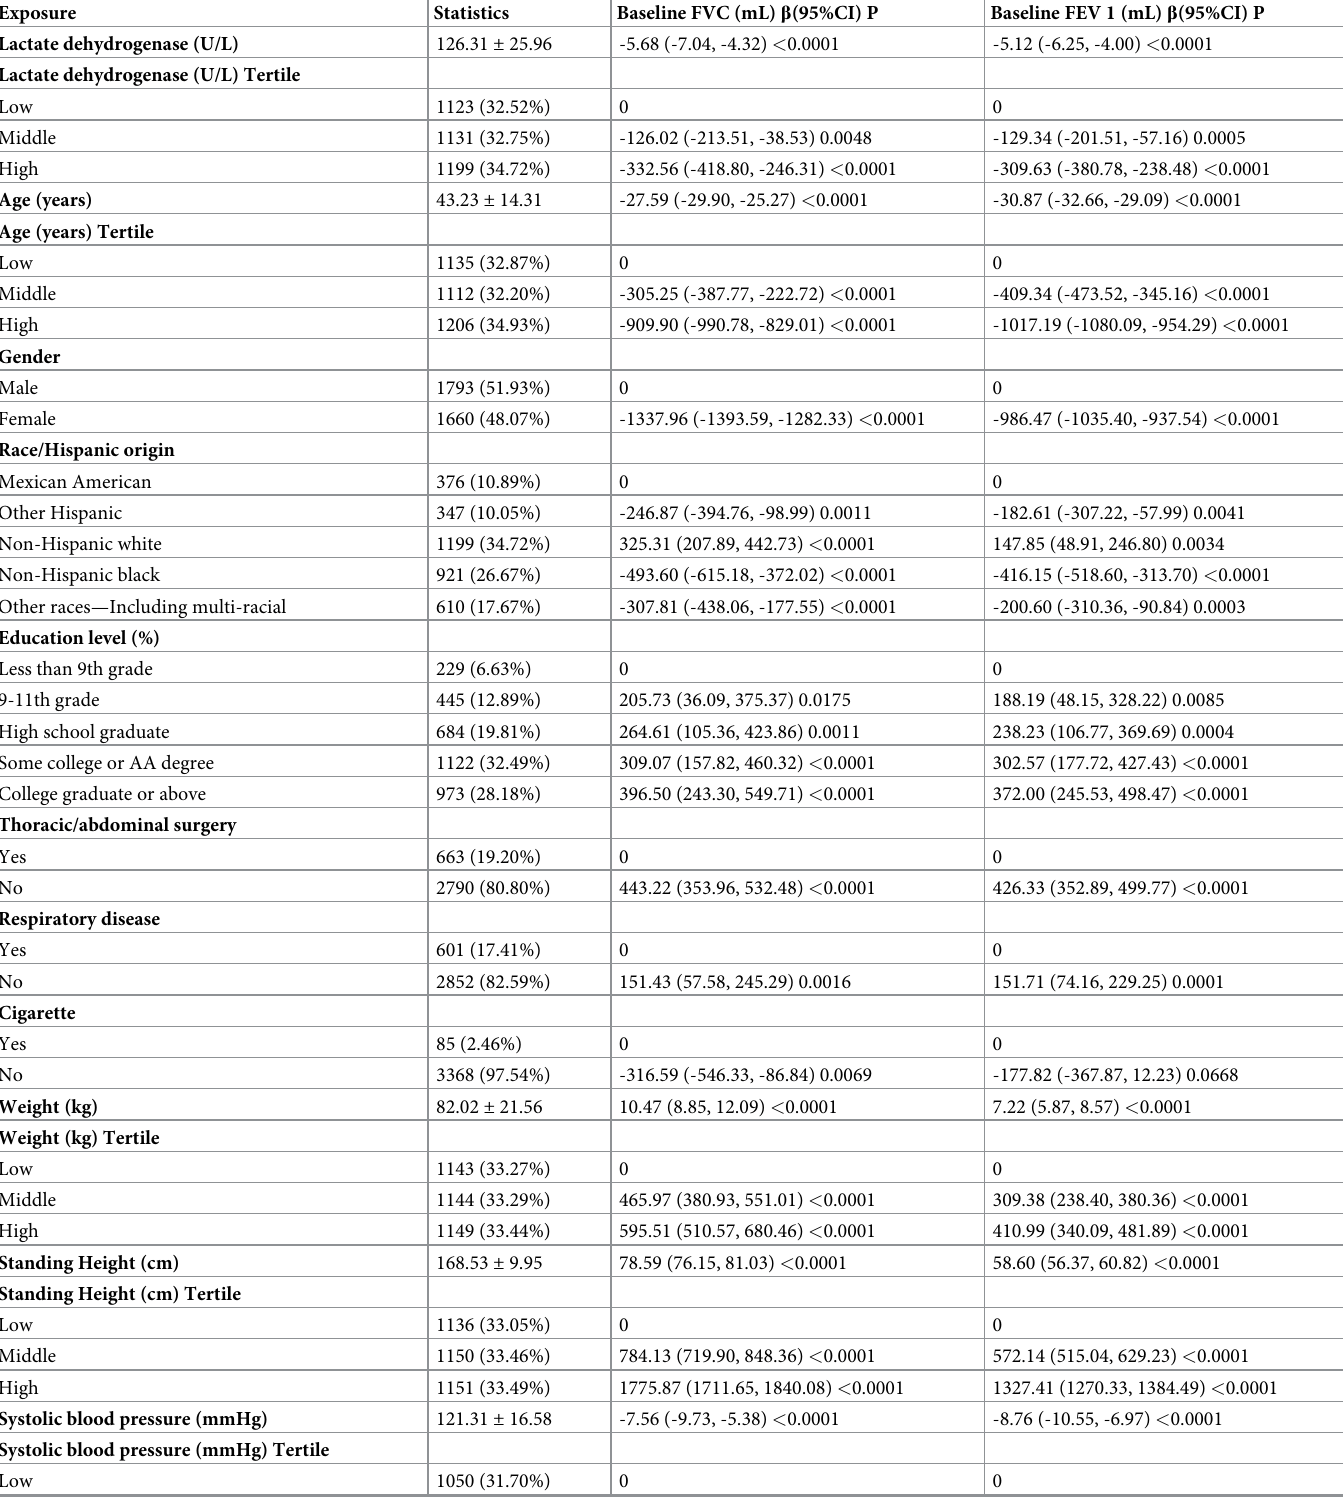
Table 2. Crude univariate analysis for baseline FVC and baseline FEV